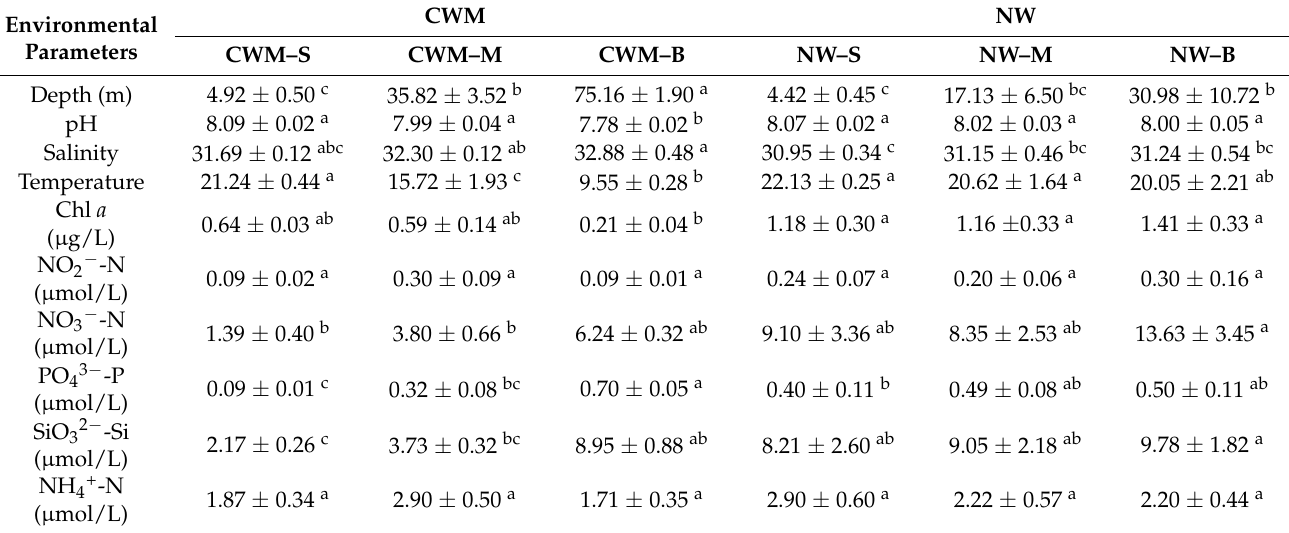
Table 2. Statistics of environmental parameters in the two